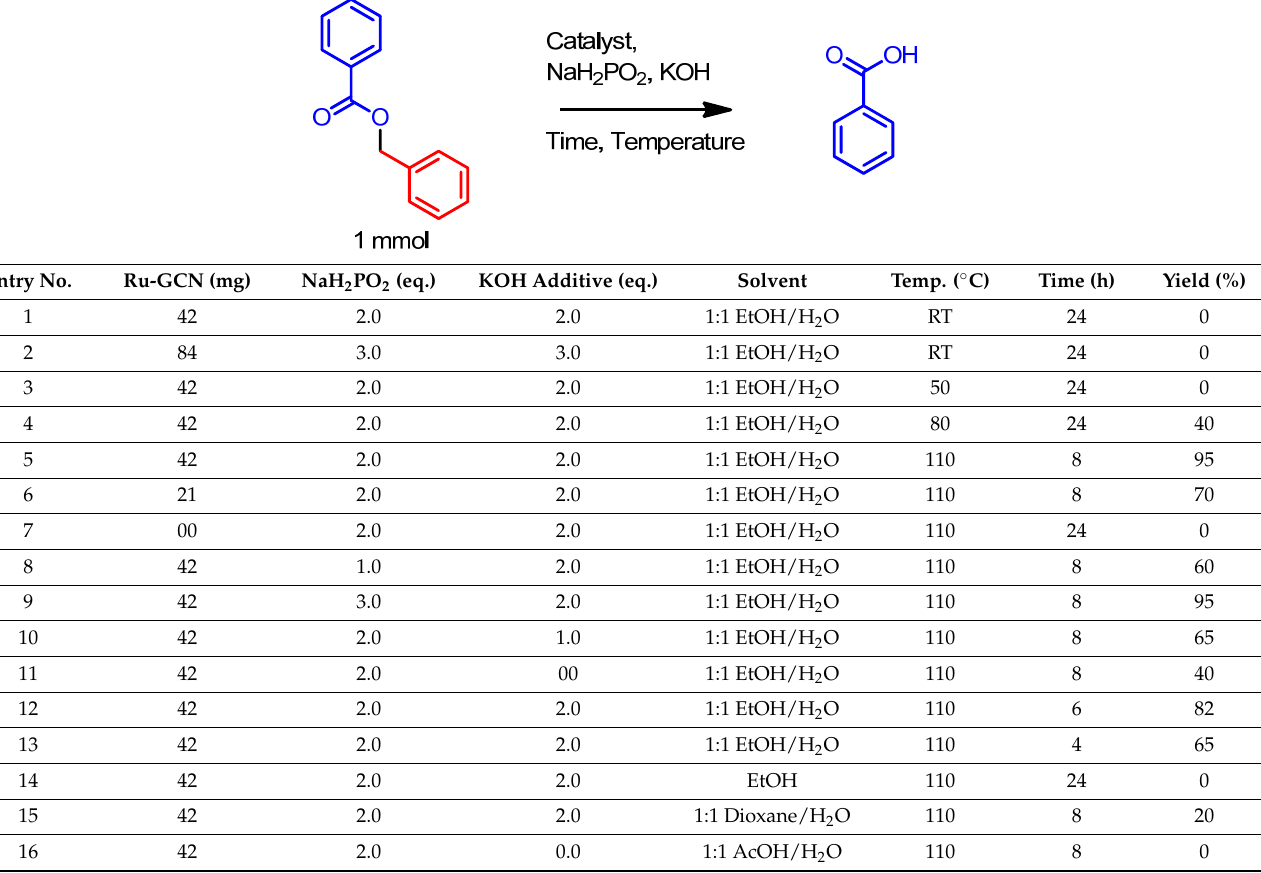
Table 1. The optimization of Ru-GCN catalyzed hydrodebenzylation reaction.